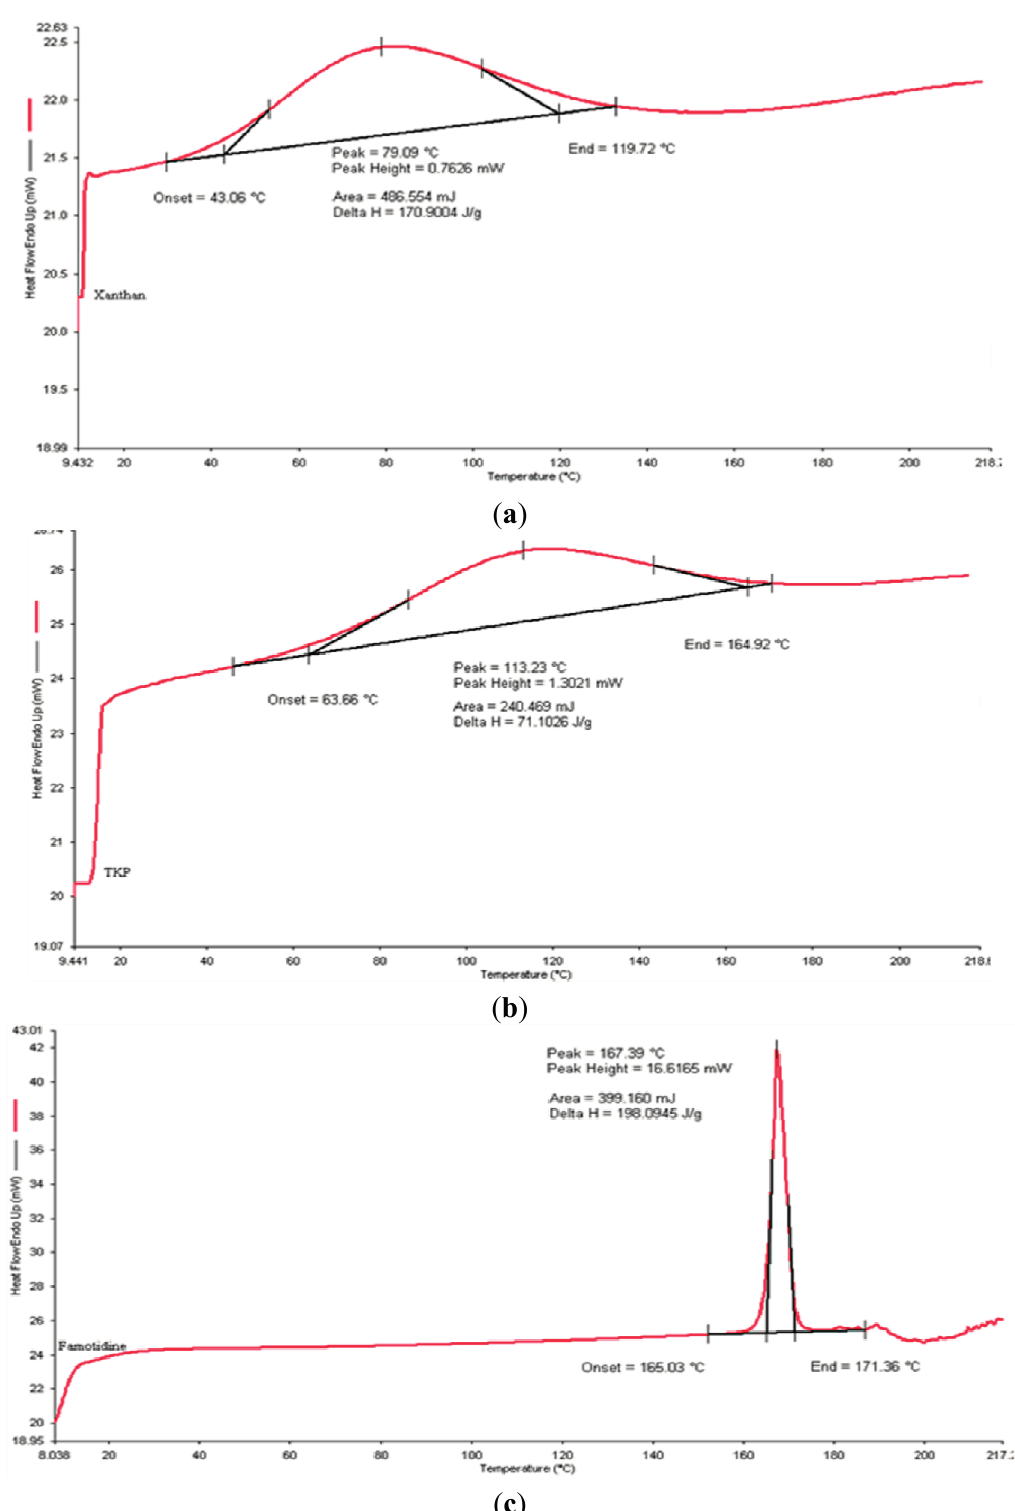
Figure 7. DSC thermogram of ( a ) pure famotidine, ( b ) TKP, ( c ) xanthan and ( d ) crushed optimum matrix tablet of